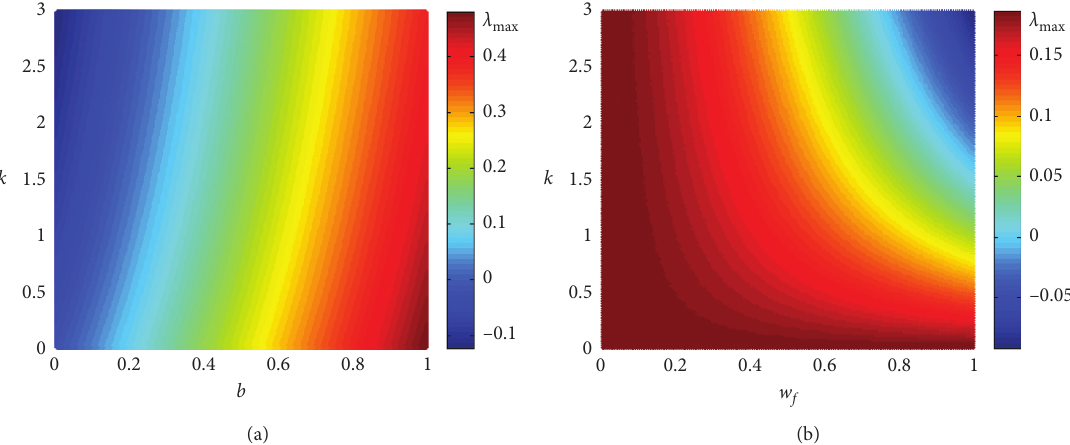
Figure 13: Behaviors of system (2) with respect to ( b − k ) , ( w zones (where λ < 0) are in blue and the other zones (where λ max